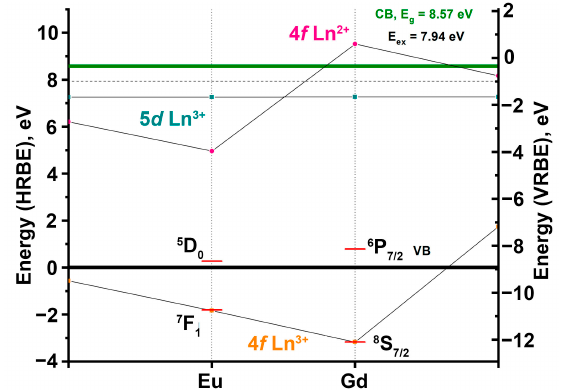
Figure 8. Energy position of the ground and excited levels of 4 f Ln 3+ (orange squares), ground levels 5 d Ln 3+ (cyan squares), 4 f Ln 2+ (pink dots) for Ca 8 Zn Ln (PO 4 ) 7 ( Ln 3+ = Gd, Eu). Lower black bold line corresponds to the top of the valence band (VB), upper green bold line—bottom of the conduction band (CB). Dashed line near CB—the exciton formation energy (E ex ).